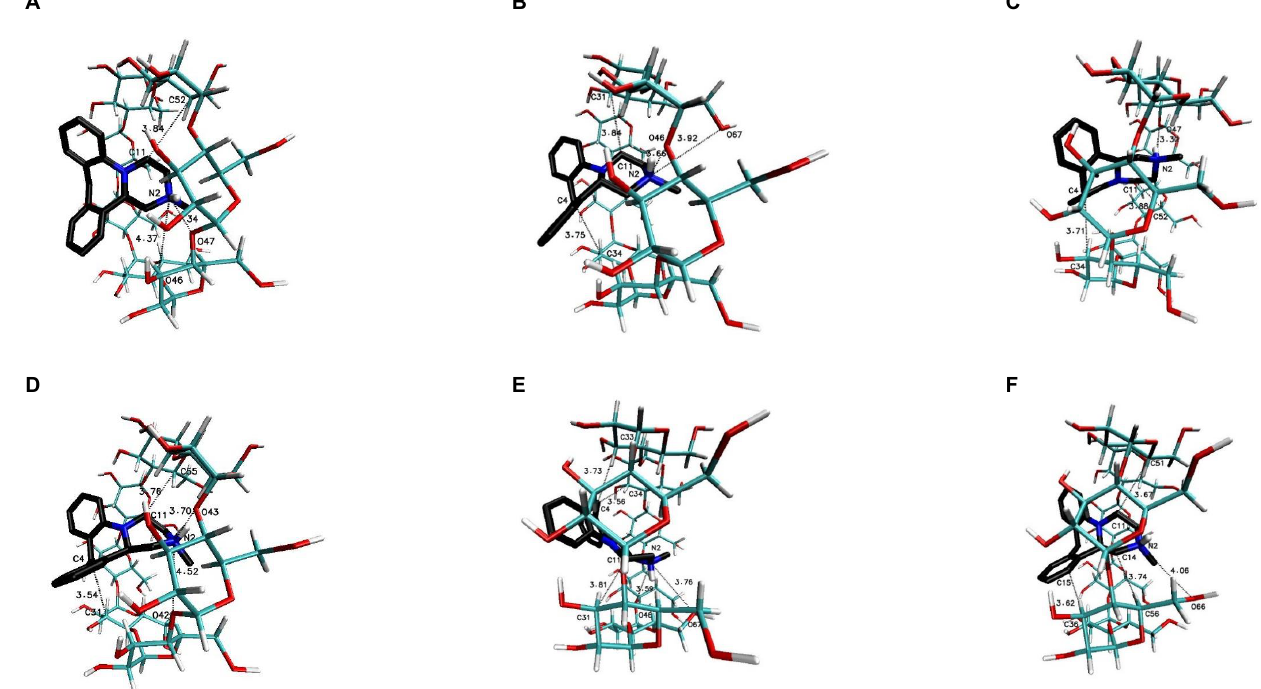
FIGURE 7 The chosen geometries of the MIA-βCD complex with stoichiometry 1:1 (I for D1 , D2 and II for E1 , E2 and III for F1 , F2 ) obtained by MD Figure 7. The chosen geometries of the MIA– β -CD complex with stoichiometry 1:1. I for ( A , D ); II for ( B , E ); and III for ( C , F ) simulations with the use of βCD crystal structure with refcode 648855 from the CSD data base [38]; D1 , E1 , F1 for S-(+)-MIA·HCl, D2 , E2 , F2 for R-(- obtained by MD simulations with the use of β -CD crystal structure with refcode 648855 from the CSD data base [38]; ( A – C) )-MIA·HCl. for S-(+)-MIA · HCl and ( D – F ) for R-( − )-MIA ·